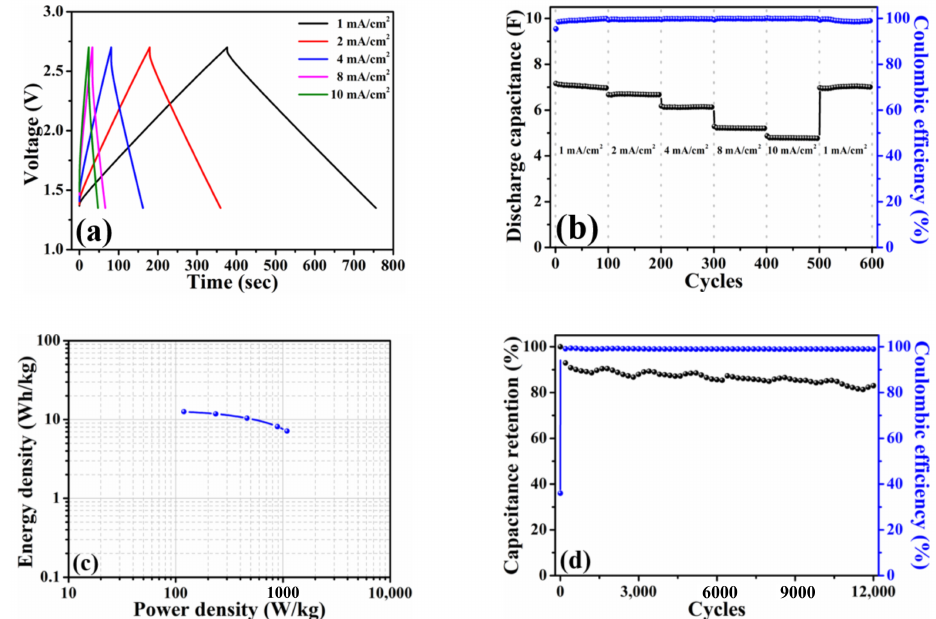
Figure 5. ( a ) Galvanostatic charge–discharge profiles, ( b ) rate capabilities, ( c ) Ragone plot, and ( d ) capacitance retention of a pouch-type symmetric cell with high-mass loading hierarchically porous activated carbon electrodes in 1.35–2.7 V. The current densities used in ( a , b ) are 1 mA/cm 2 (0.12 A/g) to 10 mA/cm 2 (1.2 A/g), while the current used in ( c ) is 245 mA (1.2 A/g and 10 mA/cm 2 ).